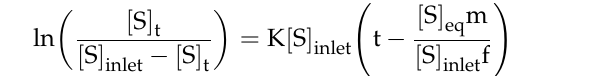
2 S uptake ( b ) adsorbent.